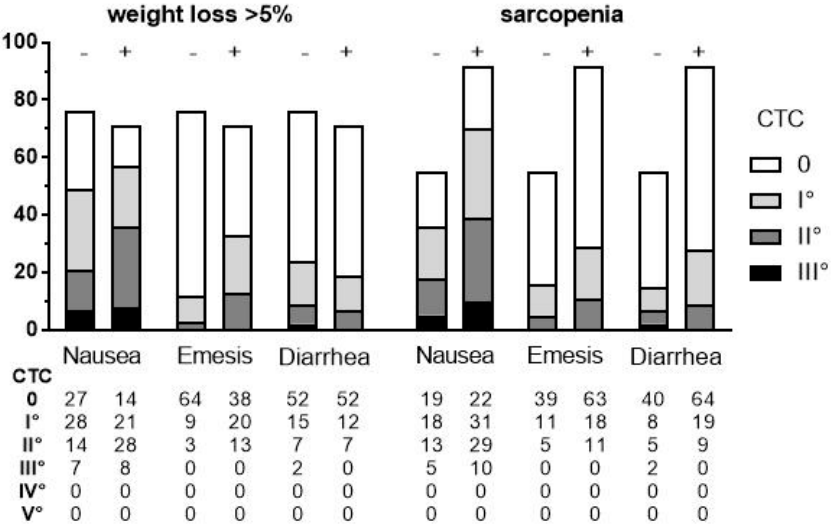
Figure 3. Distribution of National Comprehensive Cancer Network (NCCN) Common Toxicity Criteria (CTC) grades for nausea, emesis and diarrhea during chemoradiation (CRT) grouped according to the presence or absence of cachectic weight loss and sarcopenia, respectively.